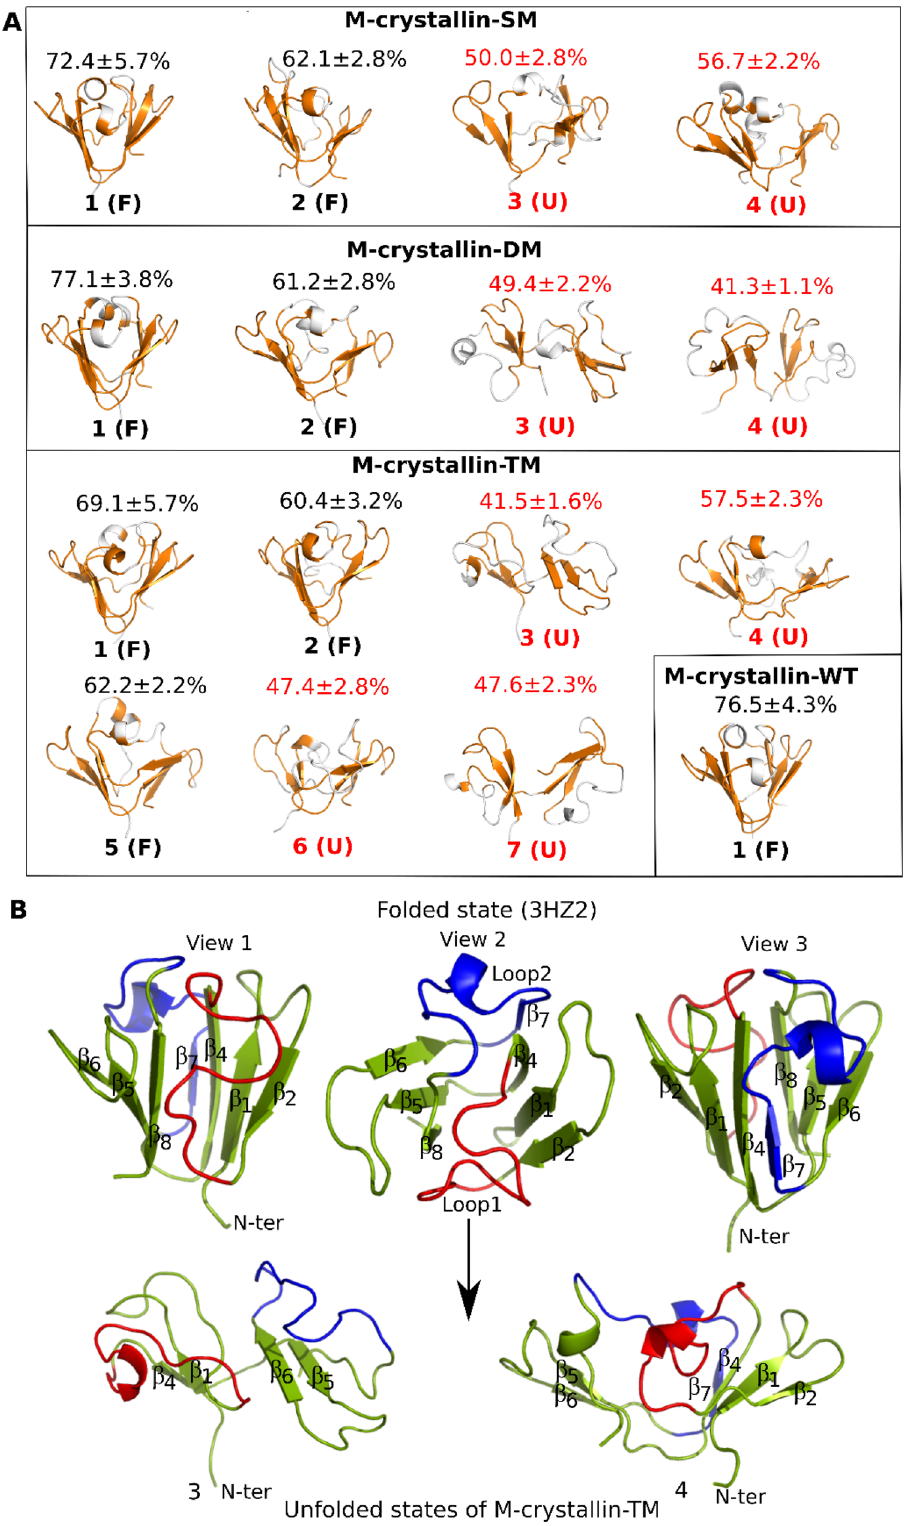
Figure 3. Native contact analysis was performed on the conformational clusters obtained from network cluster analysis. The average percentage of native contacts of a given cluster is indicated above the centroid structure ( A ). Clusters having 60% or greater native contacts are denoted as folded, F while the rest are designed as unfolded, U. In the centroid structures, the residues having native contacts are mapped in orange while rest of the residues are shown in white. ( B ) Three distinct views (one side view, top view, and opposite side view) of M-crystallin in X-ray structure are shown in top panel while unfolded representative states of M-crystallin-TM are shown in bottom panel. PyMol version 2.0.2 (https:// pymol. org/2/) is used 29